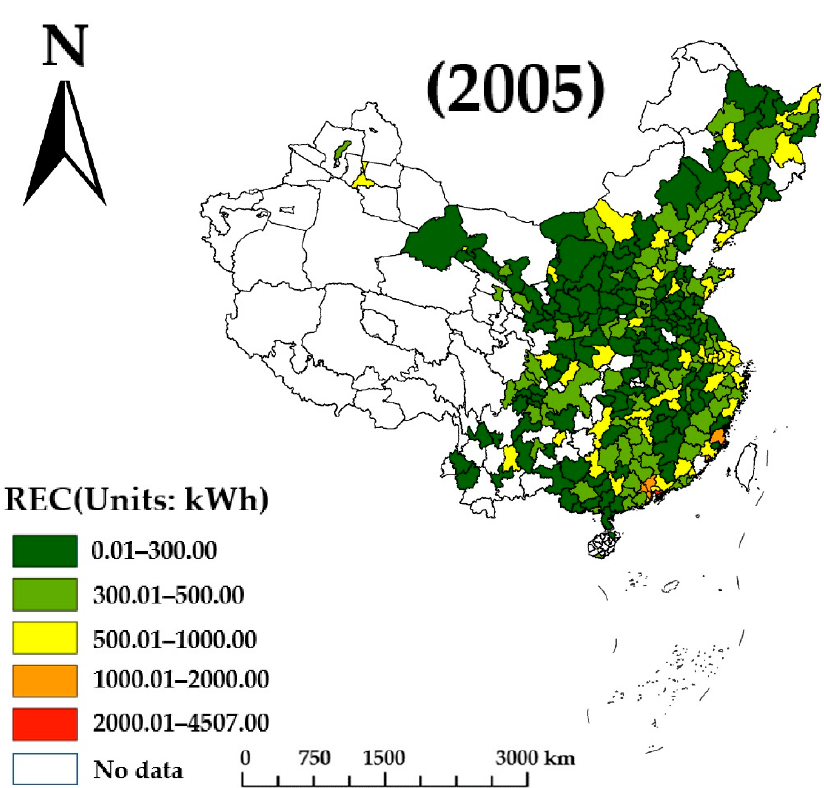
Figure 2. Spatial pattern evolution of China’s REC in 2005.